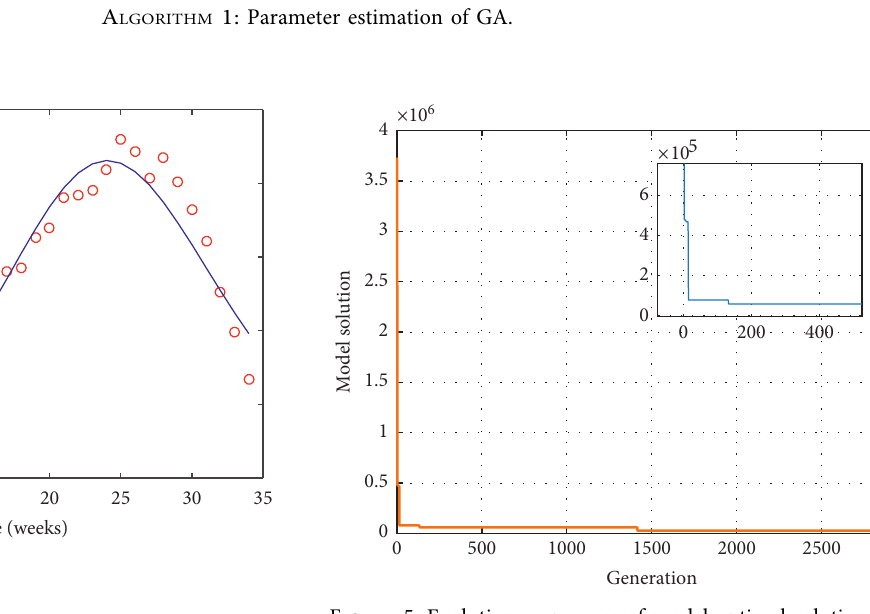
Figure 4: The fitting result for actual data of Ebola virus disease in Sierra Leone for 34 weeks with the deterministic model (1).